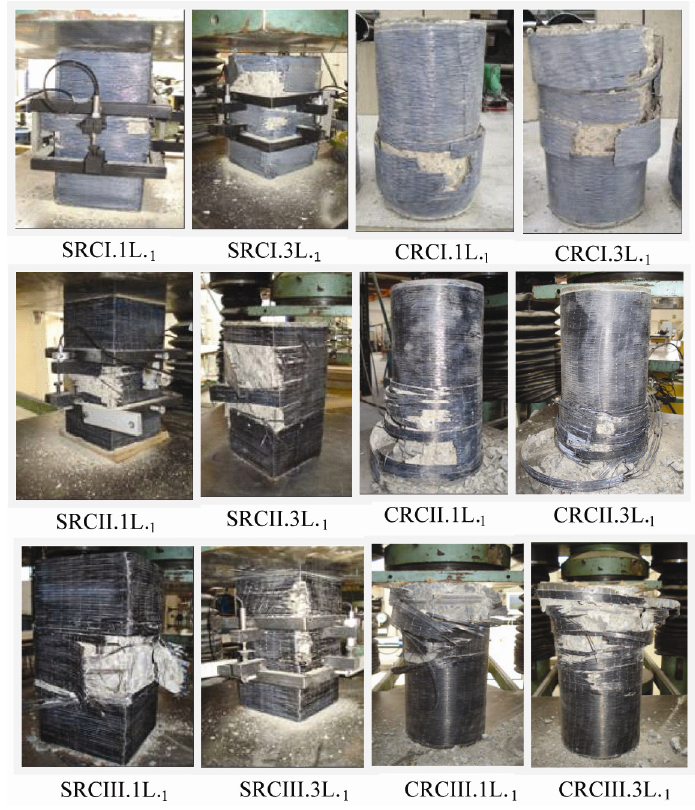
Fig. 11. Typical failure modes for the tested